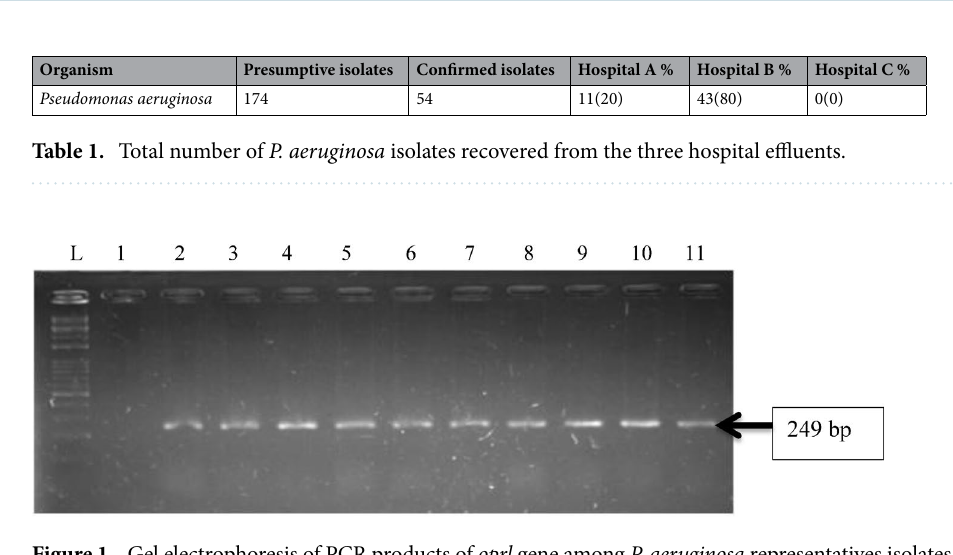
Figure 1. Gel electrophoresis of PCR products of oprl gene among P. aeruginosa representatives isolates recovered from HWW effluent. Lane 1: DNA Marker (100 bp). Lane 1: negative control. Lane 2–11: positive isolates of oprl gene (249